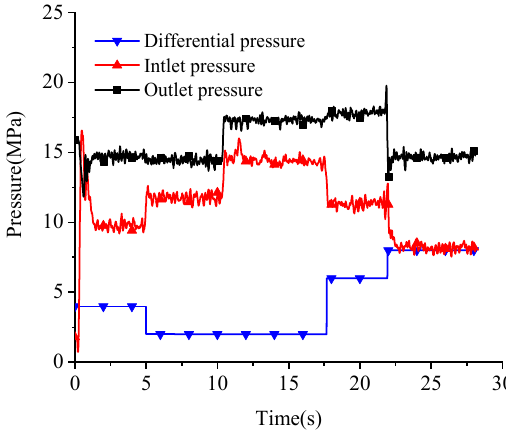
Figure 22. Differential pressure control curve.